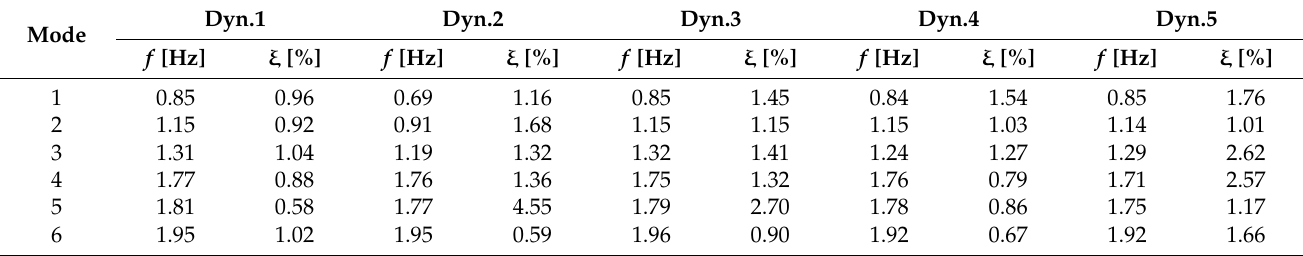
Table 5. Evolution of the experimental frequencies and damping ratios during the main phases of the proof load